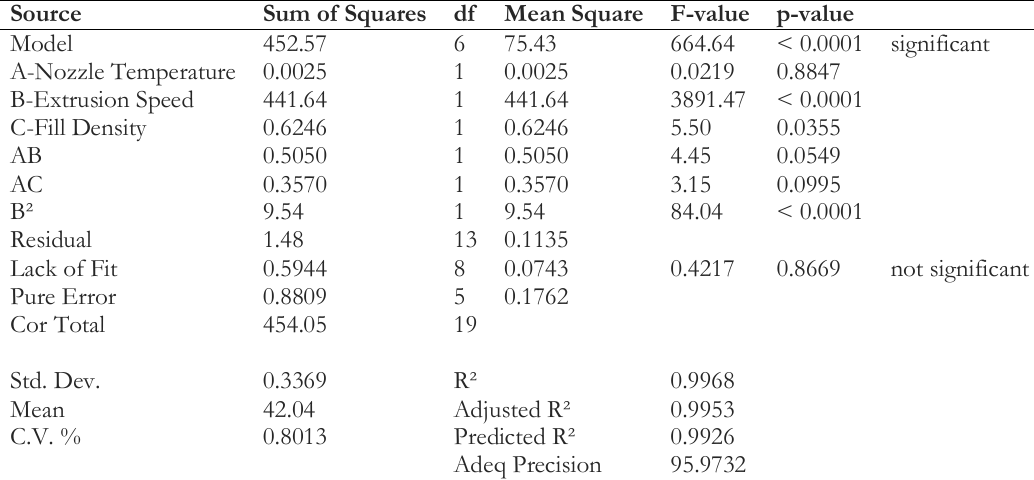
Table 7. ANOVA for main and interaction effects on extrusion time.